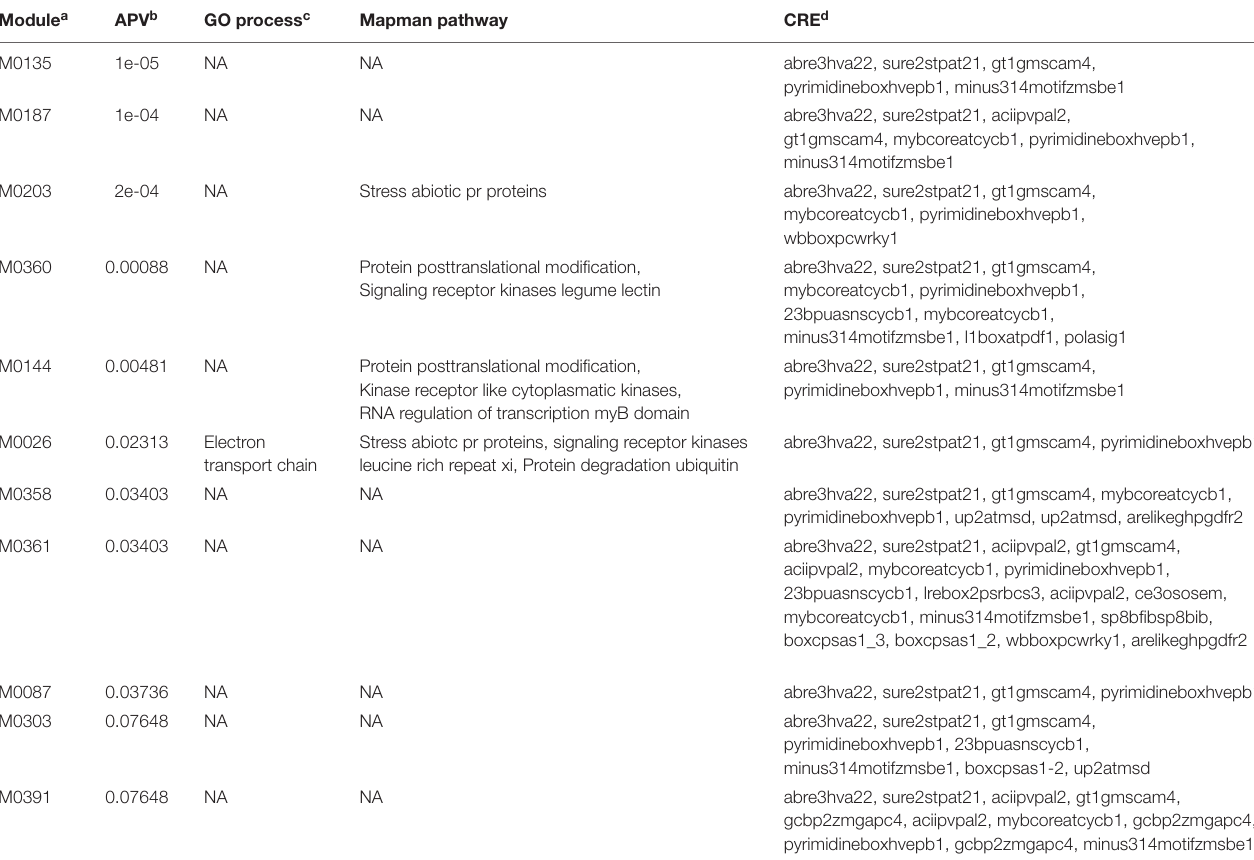
TABLE 3 | Gene ontology enrichment analysis of top 100 putative candidate genes identified using significant GWAS SNPs ( p < 0.001) associated with panicle length (cm) in the panel under HNT stress. Module a APV